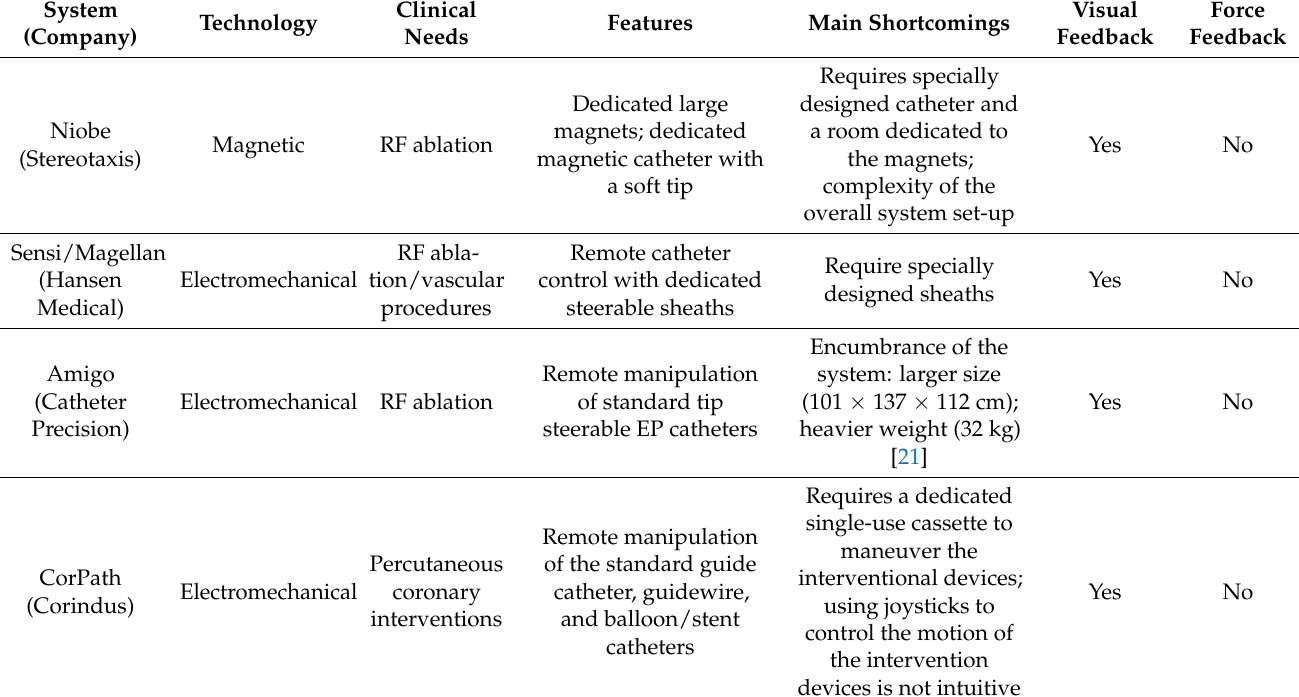
Table 1. Commercial robotic